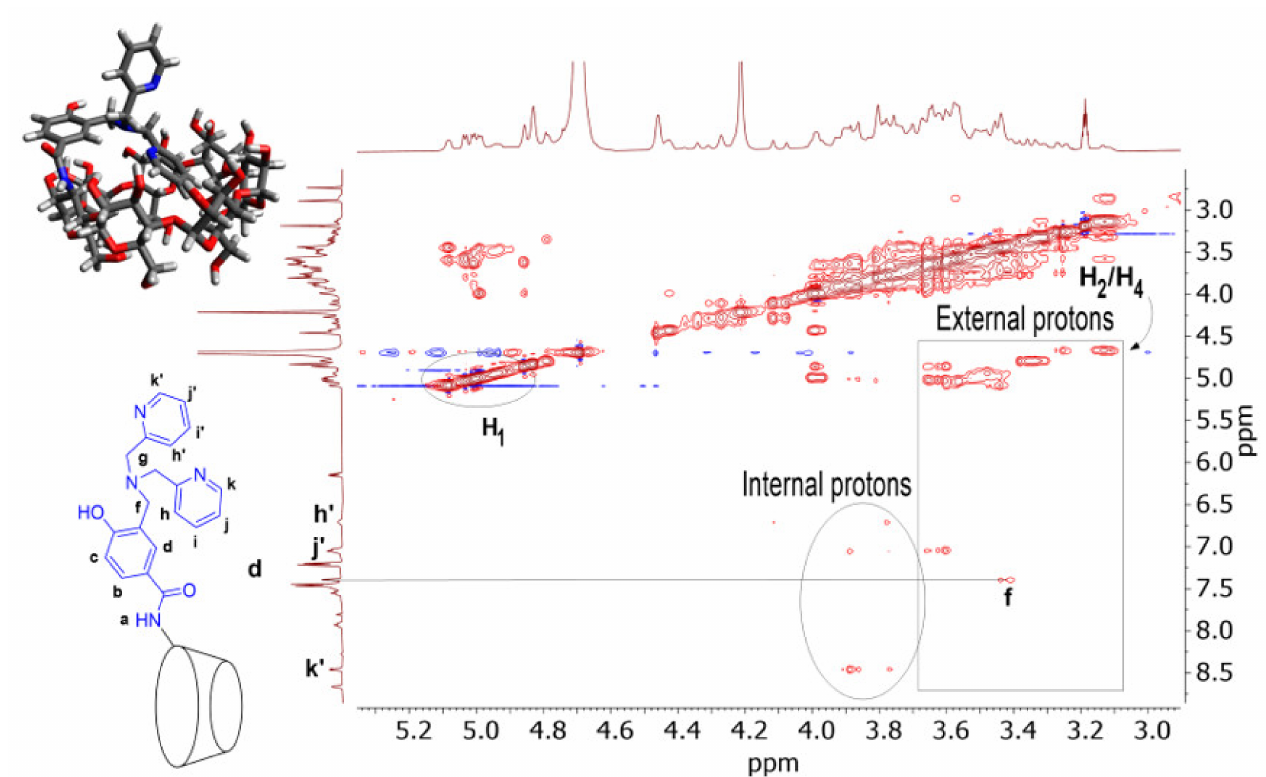
Figure 5. A 2D NOESY map (500 MHz, DMSO-d 6 /D 2 O 1:10 v/v, [Na 2 CO 3 ] = 10 mM, mix = 0.5 s) spectra of [4-Fc-PB] = 5 mM + [Zn 2+ /dpa- p -HB- β -CD] = 5 mM